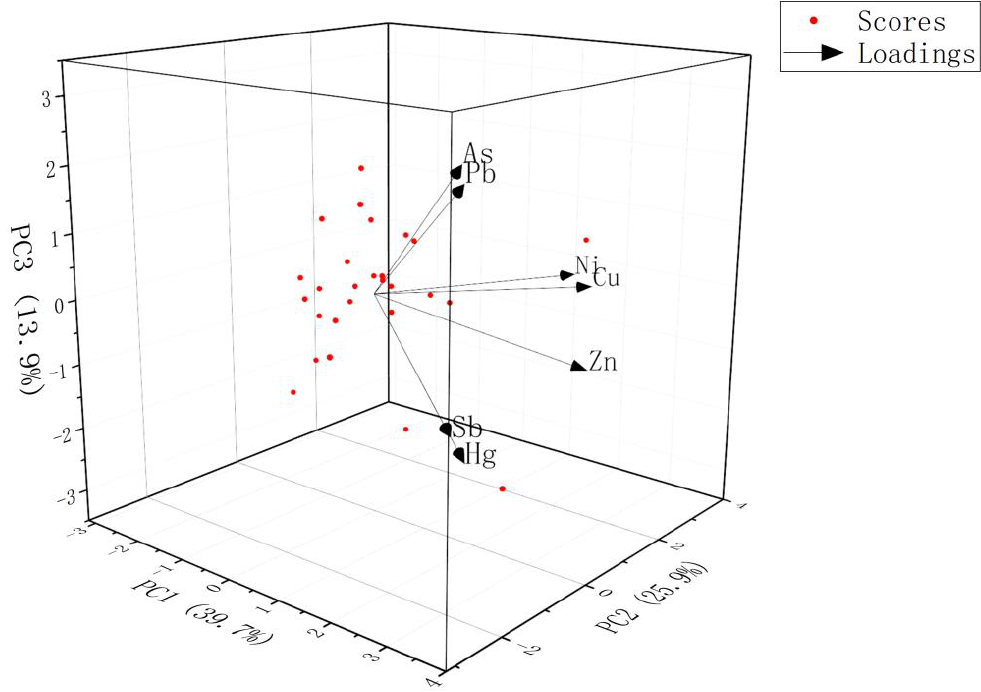
Figure 4. Three-dimensional principal component loading plot of the PCA results.